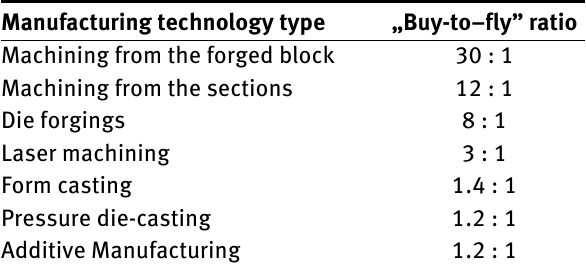
Table 1: A comparison of ”buy-to-fly” ratios for various